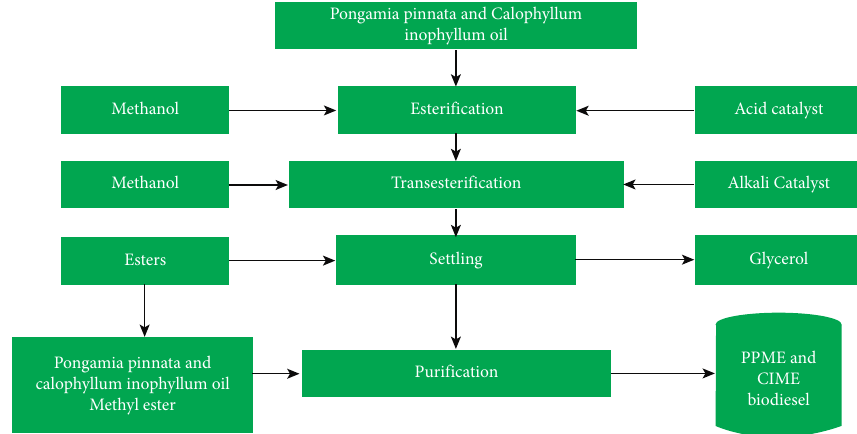
Figure 3: Procedure of biodiesel preparation. Table 3: Tested sample fuel properties.